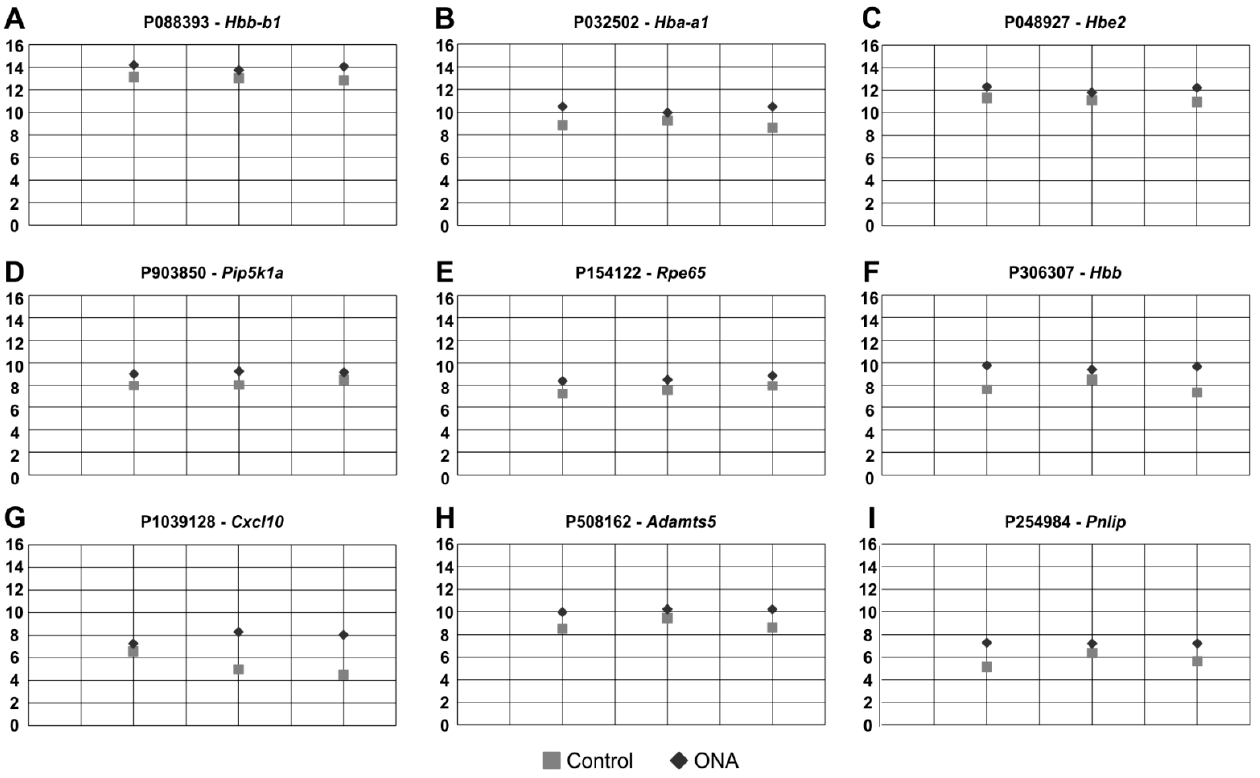
Figure 6. Upregulated oligonucleotide probes. ( A – I ) These nine oligonucleotide probes were found upregulated in ONA animals following microarray analysis of the inner retinal layers. All plots display the normalized fluorescence intensity (y-axis) of ONA and control animals (x-axis).